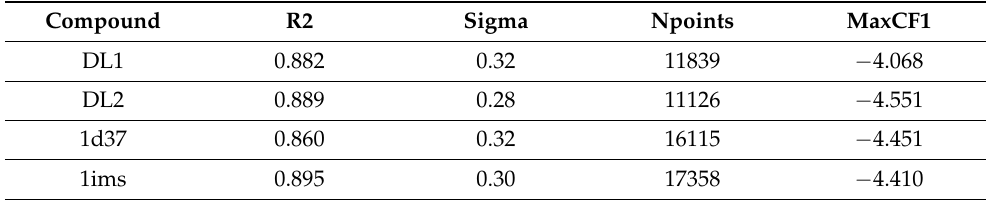
Table 9. Characteristics of the ligand-cDNA complementarity using (CF1): squared